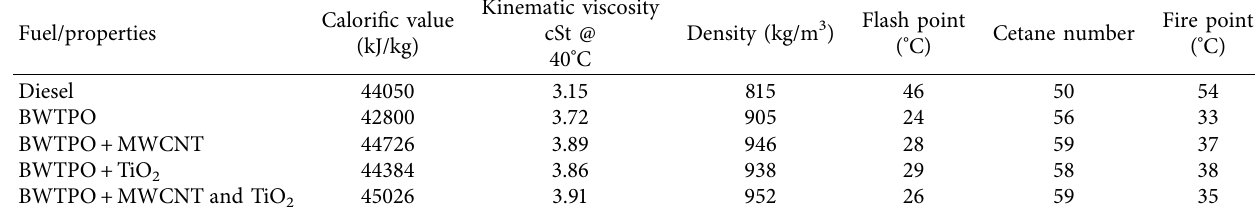
Figure 3: Nanoparticles of (a) MWCNT and (b) TiO Table 1: Properties of the fuels.